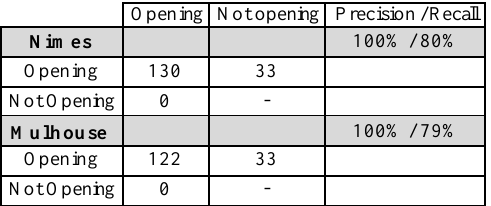
Table 1: Object-based evaluation with confusion matrix